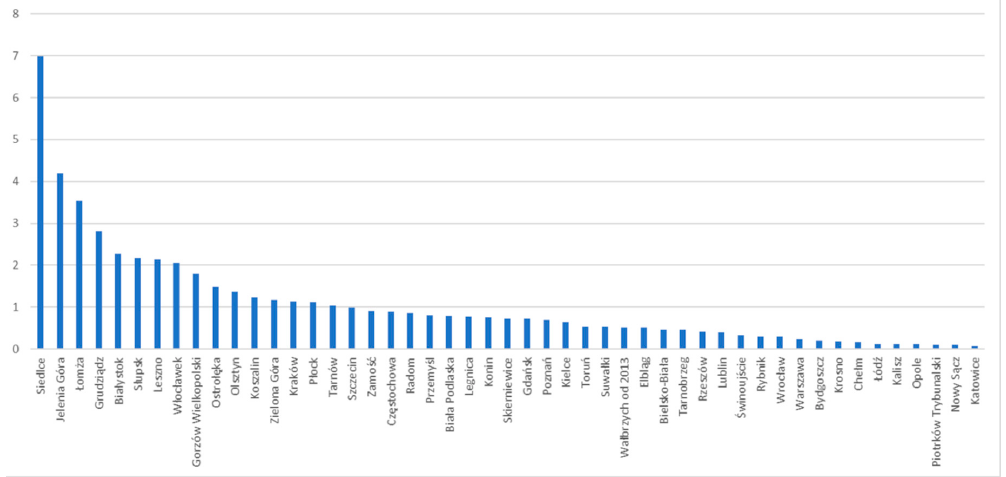
Figure 9. Ranking of cites based on the values of the OU index in 2006–2012.